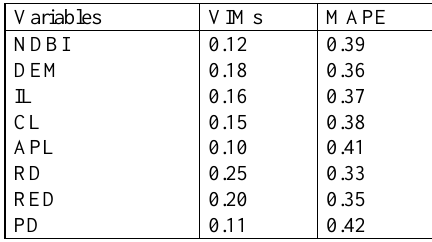
Table 4. VIMs of variables in the centre of